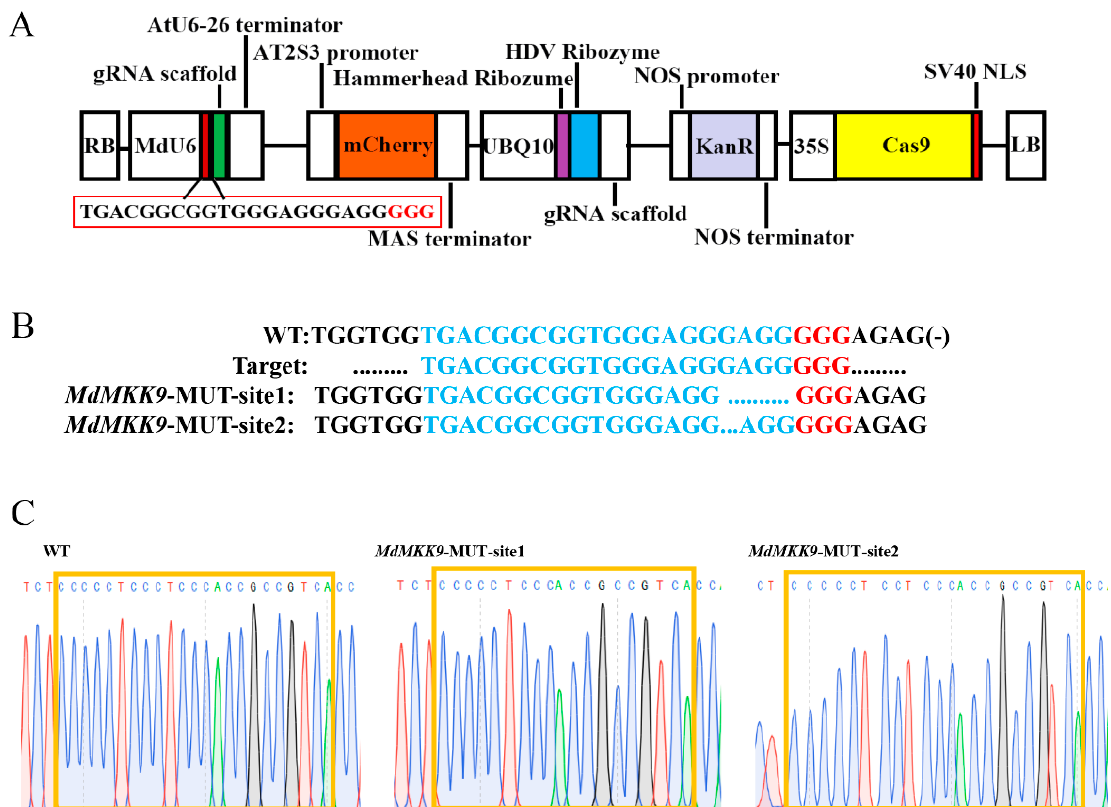
Figure 6. Mutagenesis of the MdMKK9 gene based on the CRISPR/Cas9 system. ( A ) Expression cassette of the gene-editing vector derived from pHDE-35S-Cas9-mCherry-UBQ. The red box indicates the target site. ( B ) MdMKK9 mutations resulting from four positive lines of gene editing. WT, wild- type. MdMKK9 -MUT-site1 and MdMKK9 -MUT-site2 represent two different clones. The blue dots indicate the missing bases. Red letters indicate the protospacer adjacent motifs. ( C ) Sequencing chromatogram of partial genomic DNA of MdMKK9 corresponding to the mutations. The orange frames indicate target sites for gene editing.